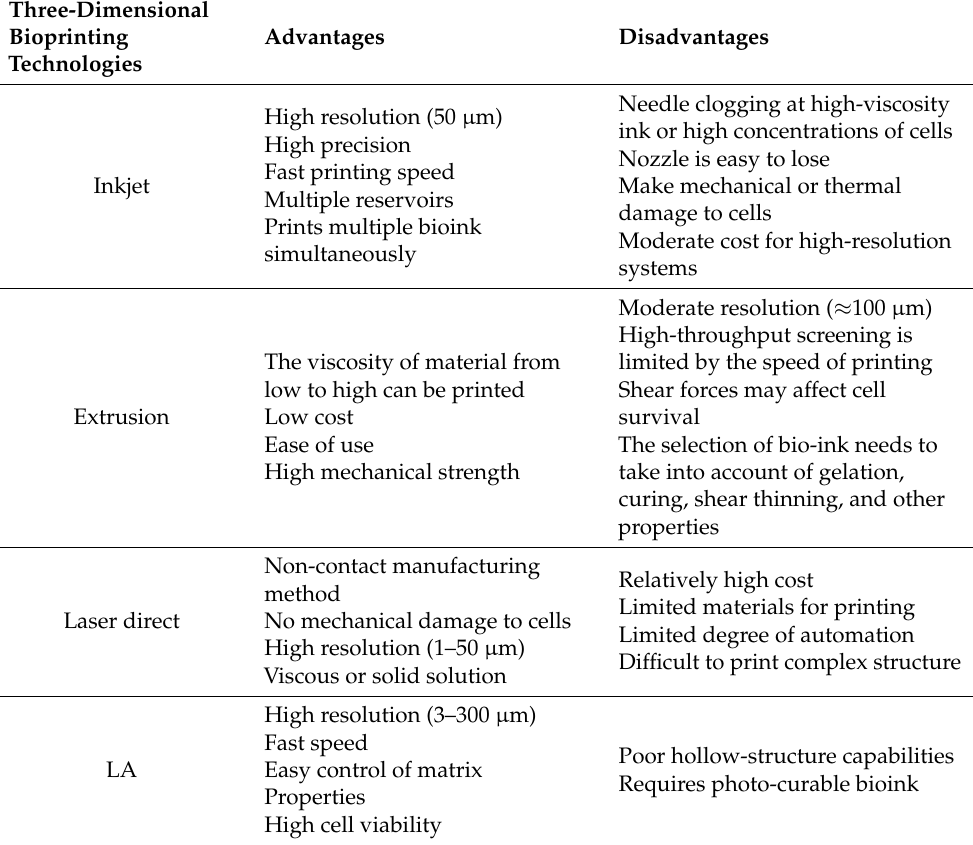
Table 3. Three-dimensional bioprinting technologies for organ-on-a-chip fabrication.